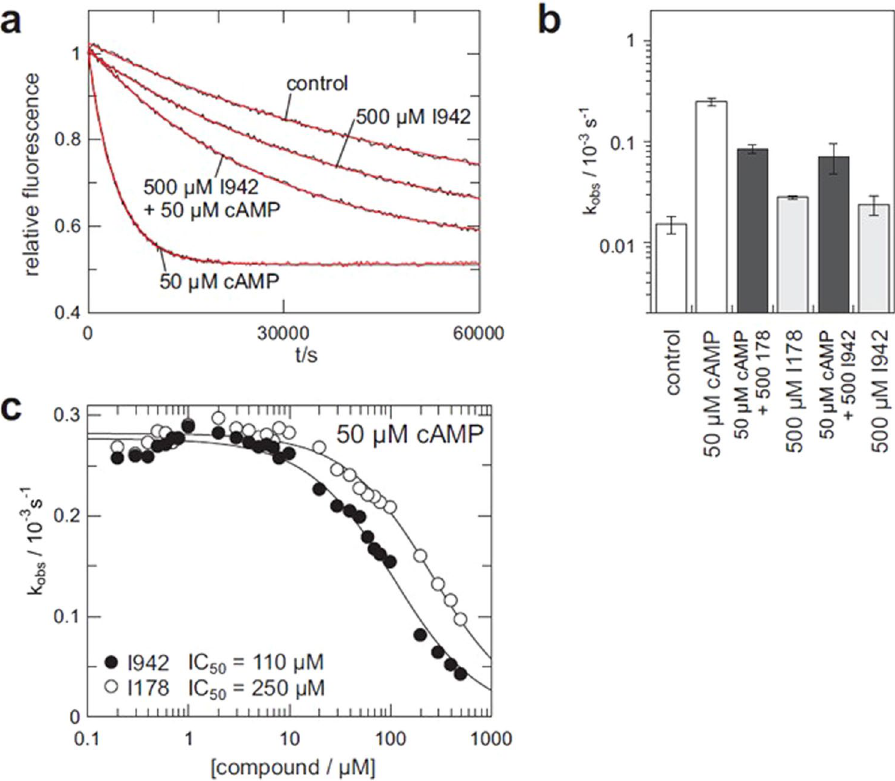
Figure 5. I942 and I178 have reduced Agonist Potential against EPAC2 Compared with EPAC1. ( a ) Time trace of the exchange reaction with recombinant EPAC2 280–993 with cAMP (50 μ M), I942 (500 μ M) or a combination of cAMP (50 μ M) and I942 (500 μ M). ( b ) Rate constants from exchange reactions (n = 4)in the presence of I942 (500 μ M), I178 (500 μ M) and/or cAMP (50 μ M). ( c ) Inhibition of cAMP induces exchange activity of Epac2 280– 993 . k μ M cAMP and various concentrations of I942 and obs were determined in the presence of 50